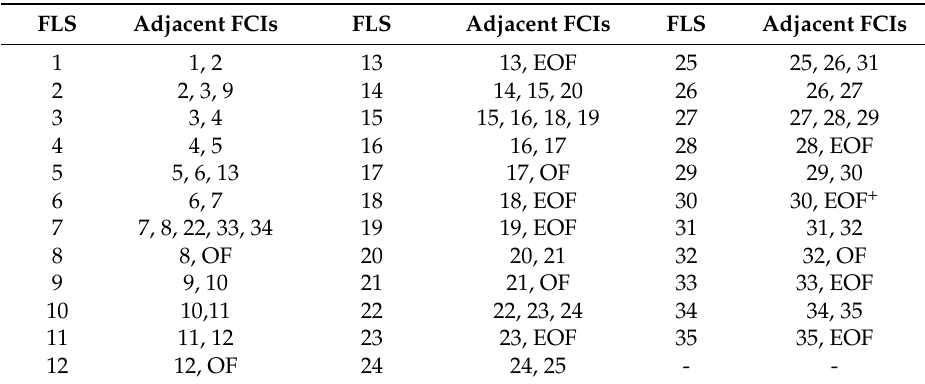
Table 7. Faulted Line Sections (FLSs) for the actual distribution